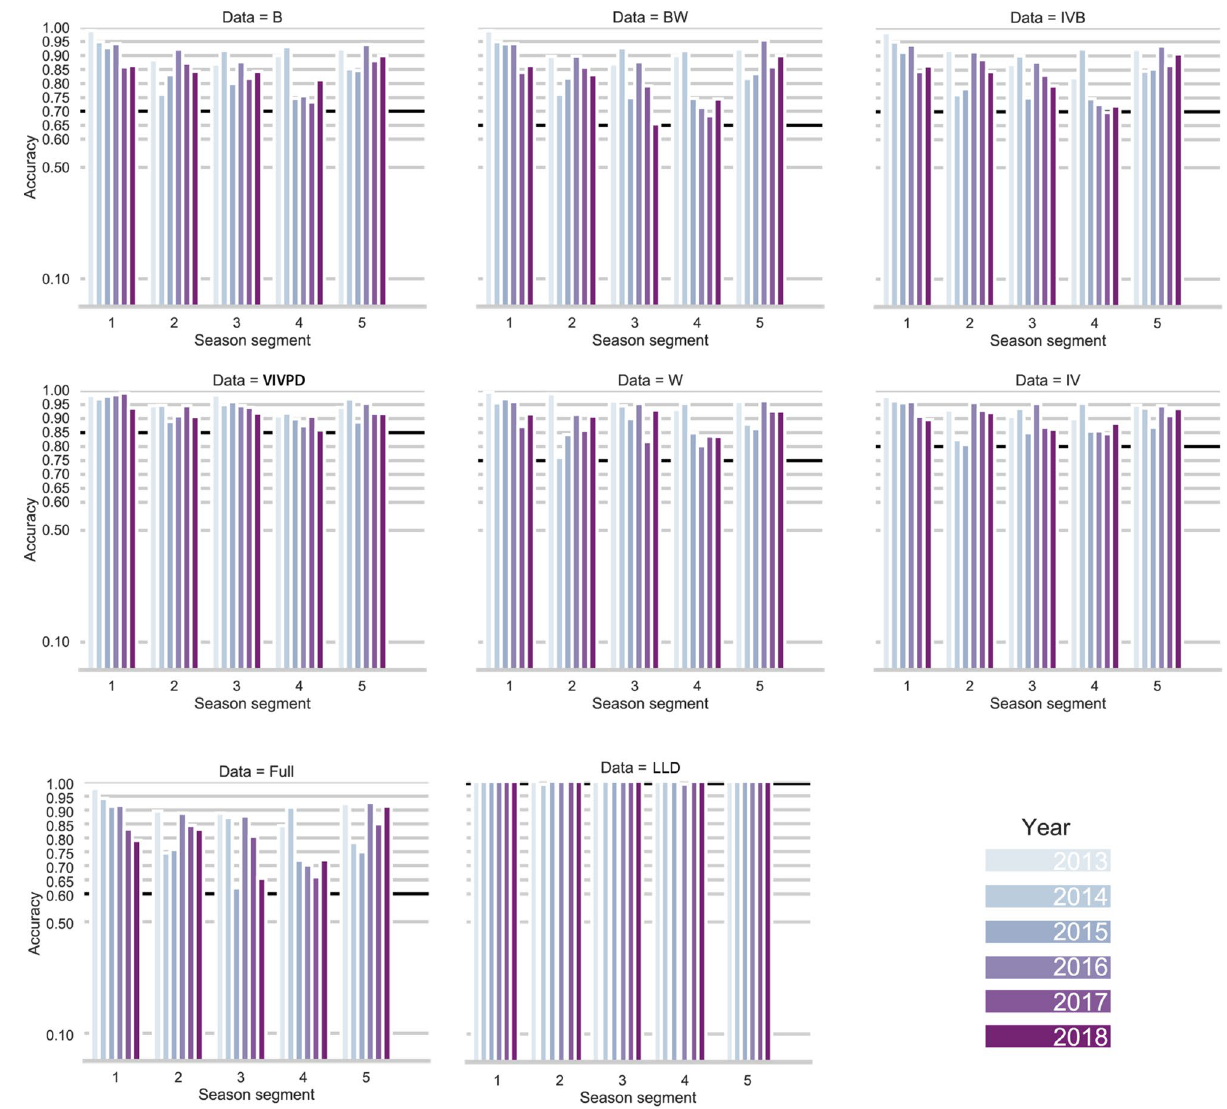
Figure 2. Accuracy values for each model during the season from 2013 to 2018. The black horizontal line shows the lowest value recorded. B spectral bands 2, 3, 4, 5, 6, 7, 10, and 11 for Landsat 8, BW spectral bands in addition to precipitation, maximum and minimum temperature, VPD, and GDU (weather parameters), VIB spectral bands in addition to NDVI, EVI, GCVI, GVMI, and NDWI (vegetation indices), VIVPD vegetation indices and vapor pressure deficit (VPD), W weather parameters, VI vegetation indices, FULL spectral bands, weather parameters, and vegetation indices, LLD latitude, longitude and